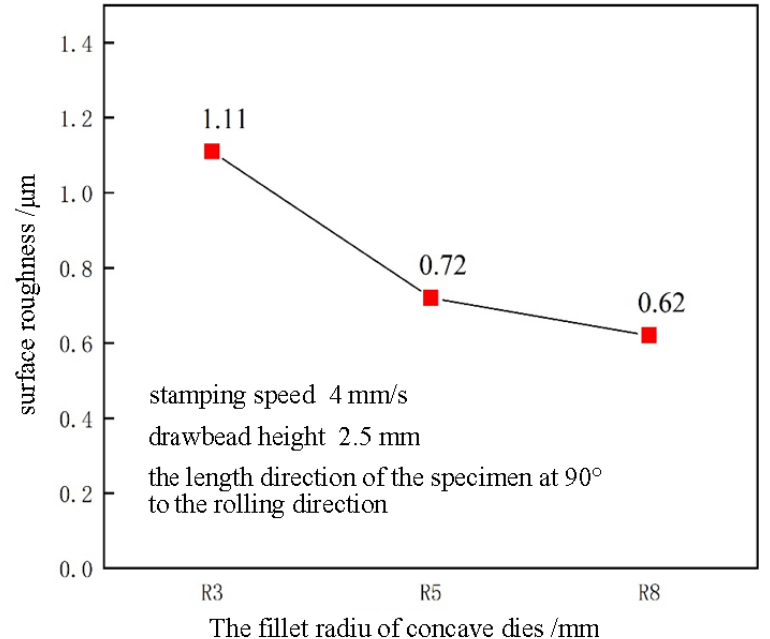
Figure 9. Surface roughness of specimens with different die fillets.